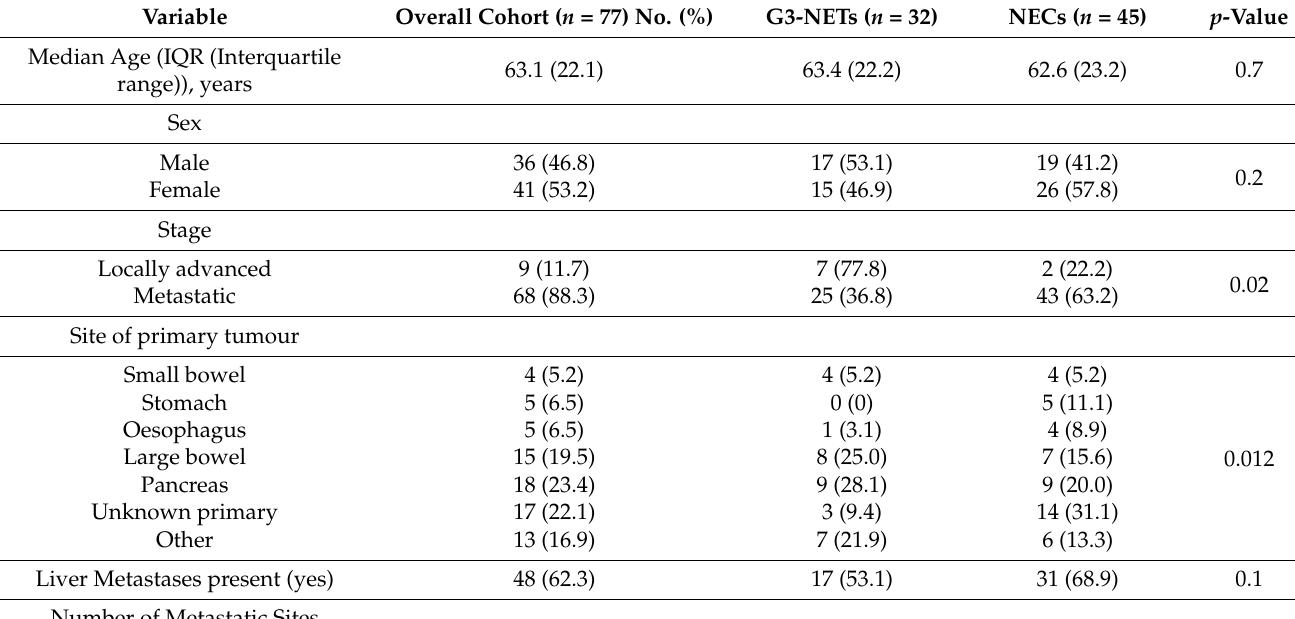
Table 2. Baseline characteristics and biochemical results of patient